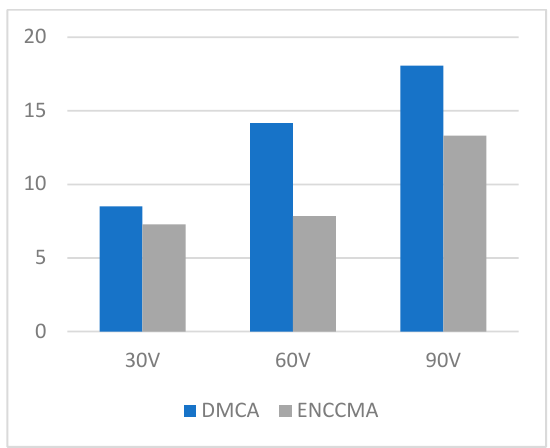
Figure 5. Throughput for the rural environment.